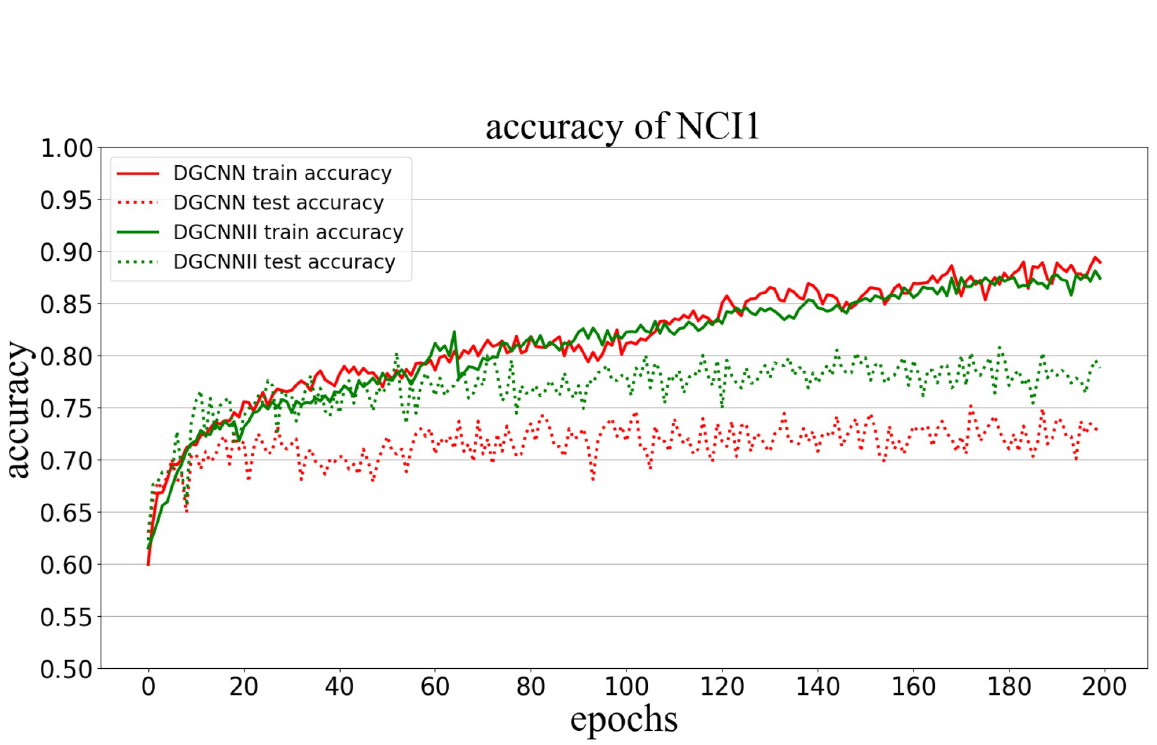
Fig 7. Comparison of graph classification accuracy between DGCNNII and DGCNN on NCI1 dataset.